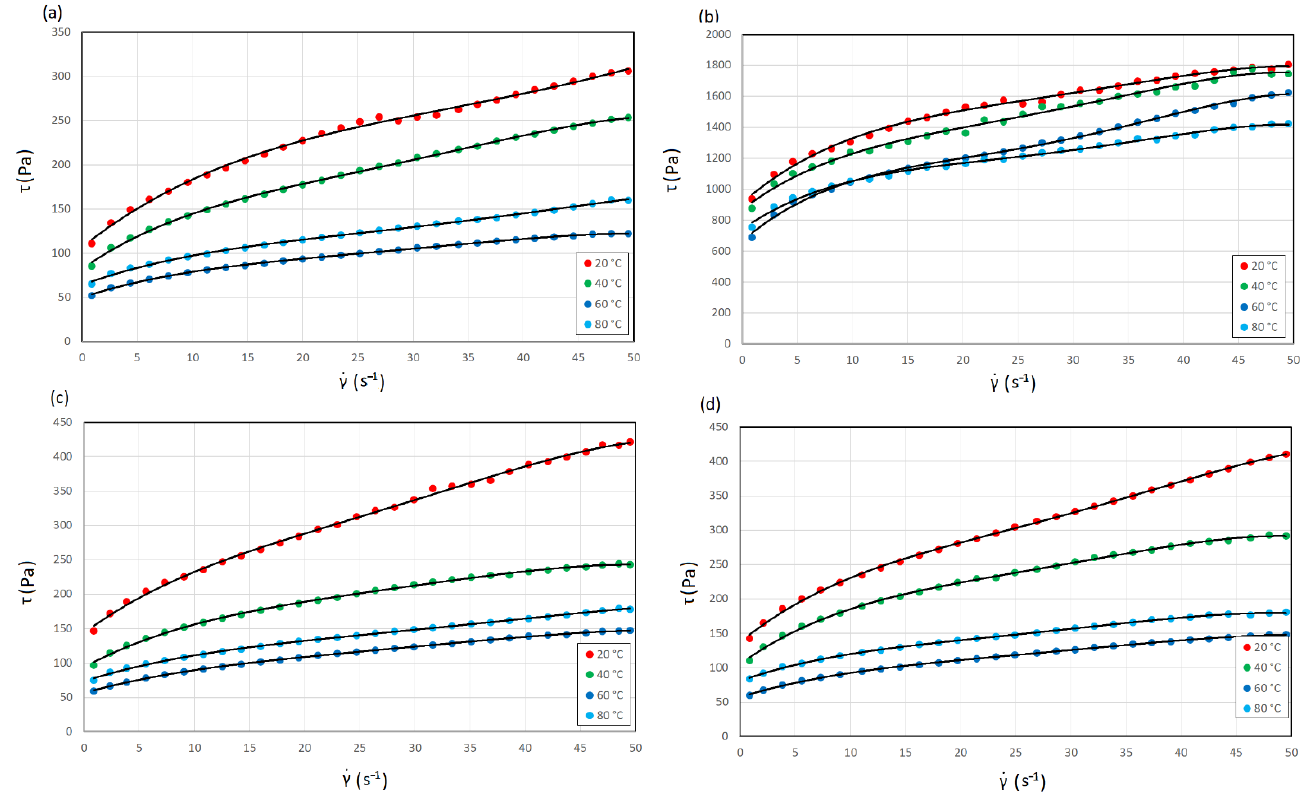
Figure 5. Herschel–Bulkley model fitted to flow curves of hot trubs as a function of shear rate at four temperatures: ( a ) hot trub from wort, 12.5°; ( b ) hot trub from wort, 14.1°; ( c ) hot trub from wort, 16.1°; ( d ) hot trub from wort, 18.2°.